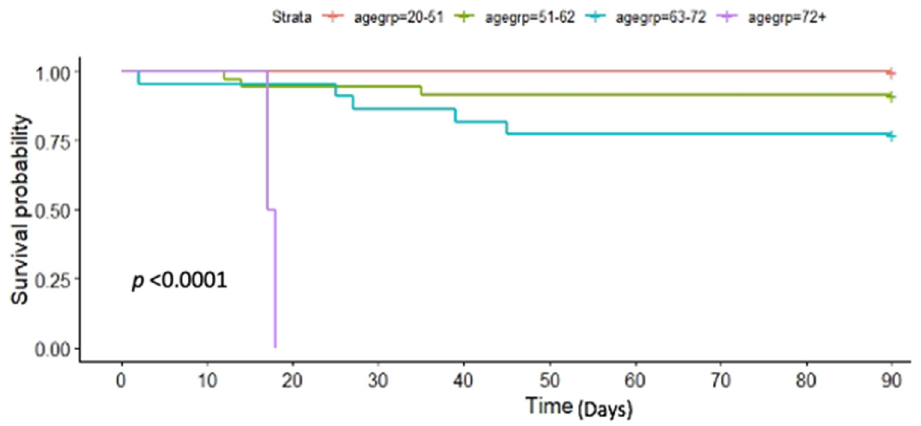
Figure 1. Kaplan-Meier survival curve of unvaccinated SARS-CoV-2 positive solid organ transplant recipients, stratified by age groups (years): 20–51, 51–63, 63–72, >72. Patient survival was inferior in the oldest age group ( p < 0.0001). Table 3. Life Table by Age